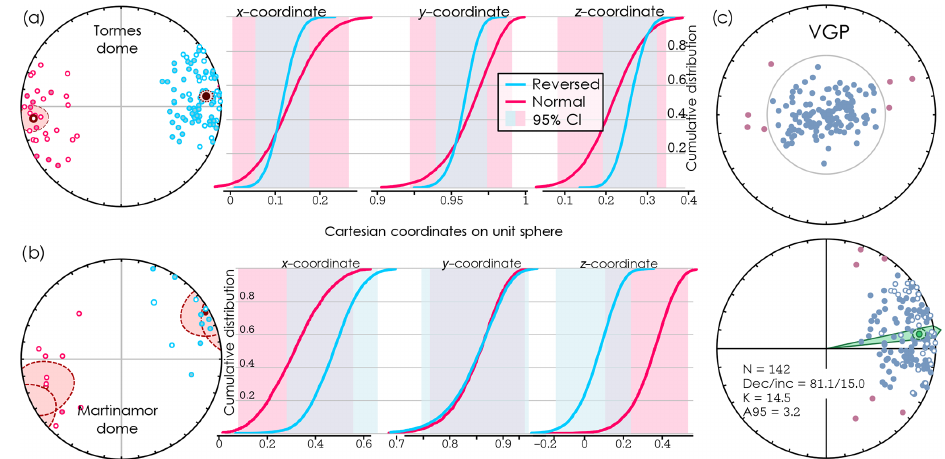
Figure 7. Magnetization components with a positive reversal test in the extensional anatectic granites of the Tormes (a) and Martinamor domes (b) . This component is interpreted as primary with a magnetization age of > 318Ma (Pastor-Galán et al., 2016). (c) Distribution of directions and VGPs and statistical parameters from both domes combined.